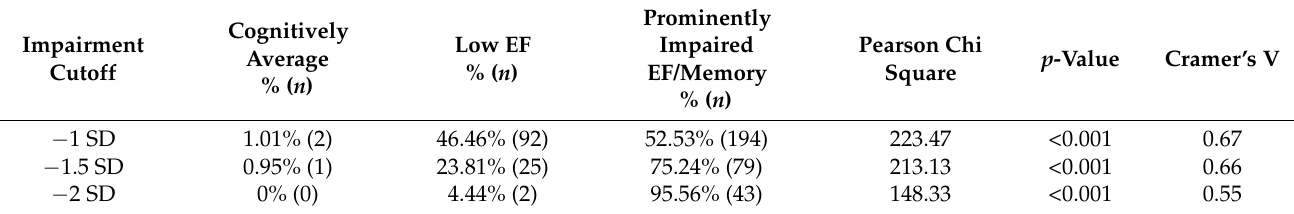
Table 4. Percentage of PD-MCI Cases Falling to Each K-Means